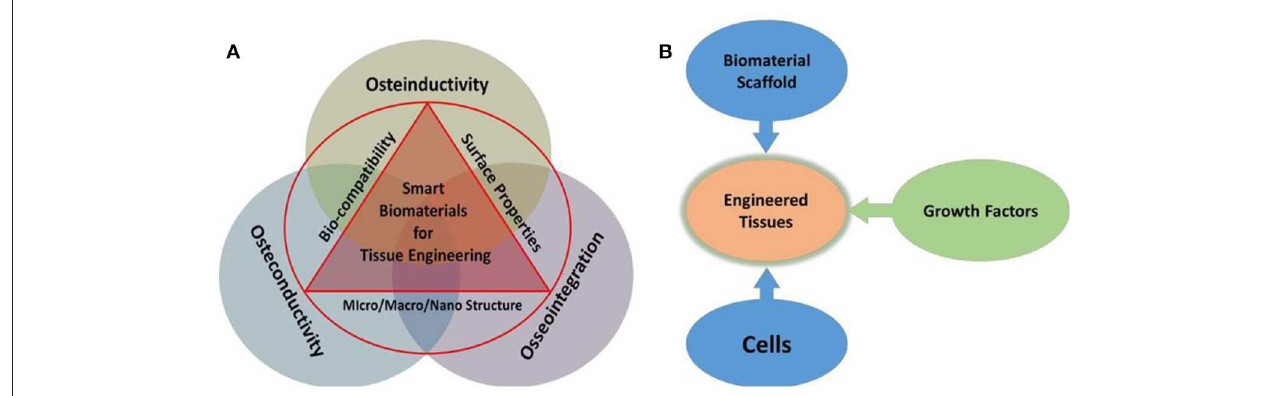
FIGURE 1 | Illustration of salient features of biomaterials required for TE (A) , and combination of biomaterials, cell, and growth factors (signaling) associated with tissue engineering (B) depicts integration of smart biomaterials with specific salient features, which facilitate osteo function and